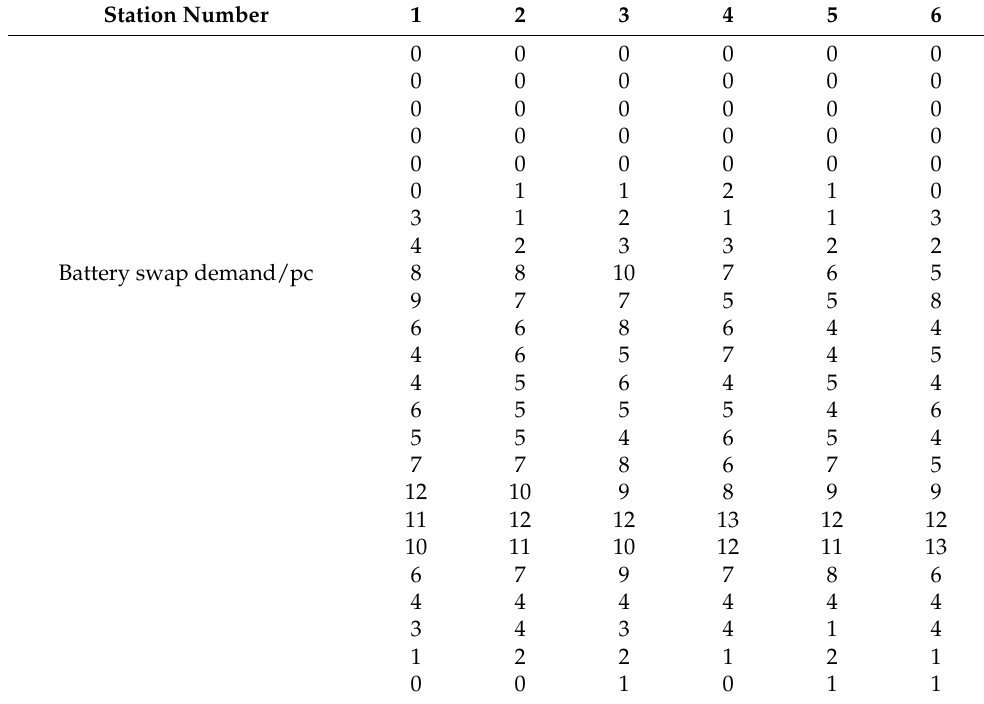
Table A1. Battery swap demand on a typical